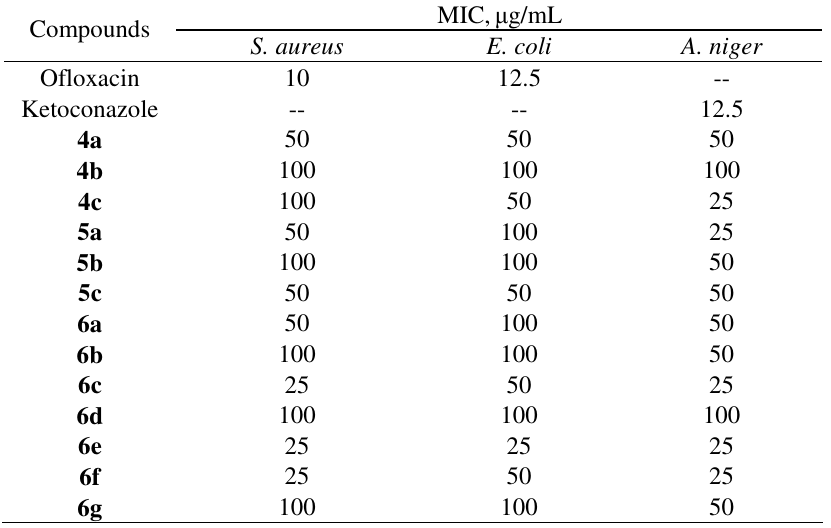
Table 2 . Antimicrobial activities of the